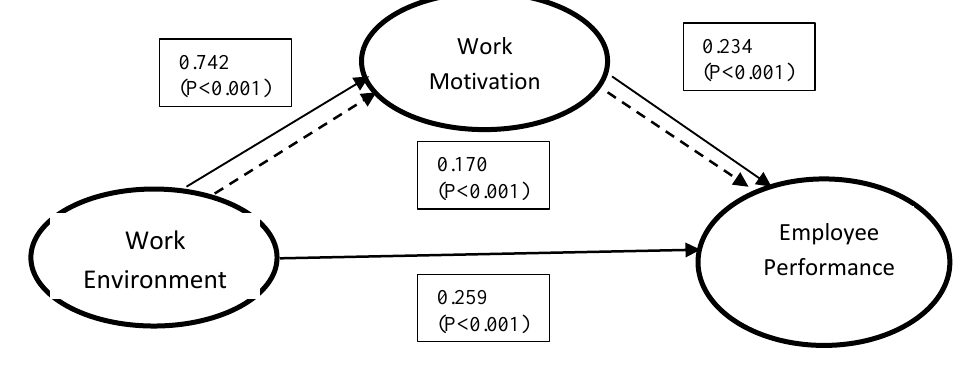
Figure 1 : Structural Model Path Diagram In PLS (Direct Effect)